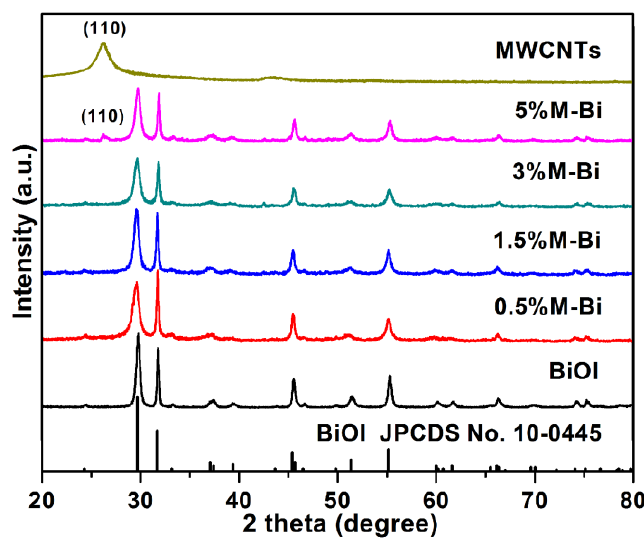
Figure 1. X-ray diffraction (XRD) patterns of as-prepared multiwalled carbon nanotubes (MWCNTs)/BiOI composites, BiOI, and MWCNTs.